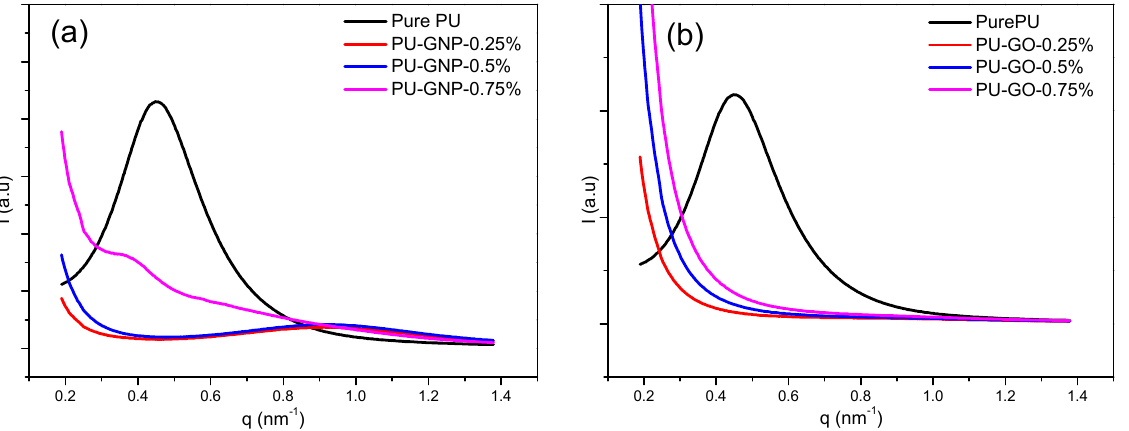
Figure 7. Semi-log plot of scattered intensity from SAXS experiments for pure PU and PU/GNP and PU/GO nanocomposites, ( a ) SAXS curves of GNP nanofiller; ( b ) SAXS curves of GO